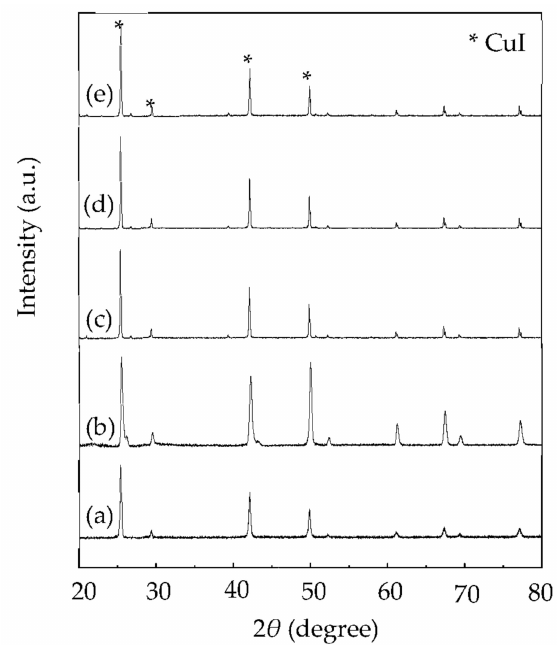
Figure 5. XRD patterns of residual copper on the Cu/ITO thin film during extraction with the IL-I at ( a ) 303, ( b ) 343, ( c ) 413, ( d ) 473, and ( e ) 543